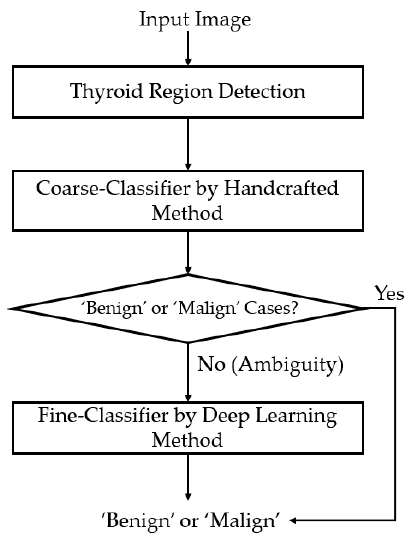
Figure 2. Flow chart of the proposed method.